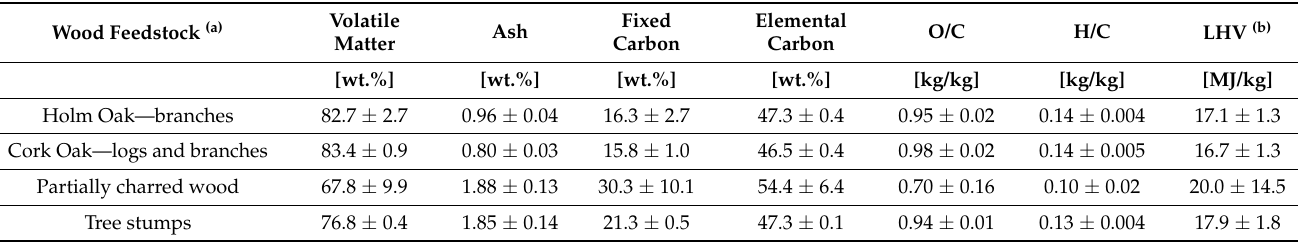
Table 1. Properties of the dry wood feedstocks used in the carbonization